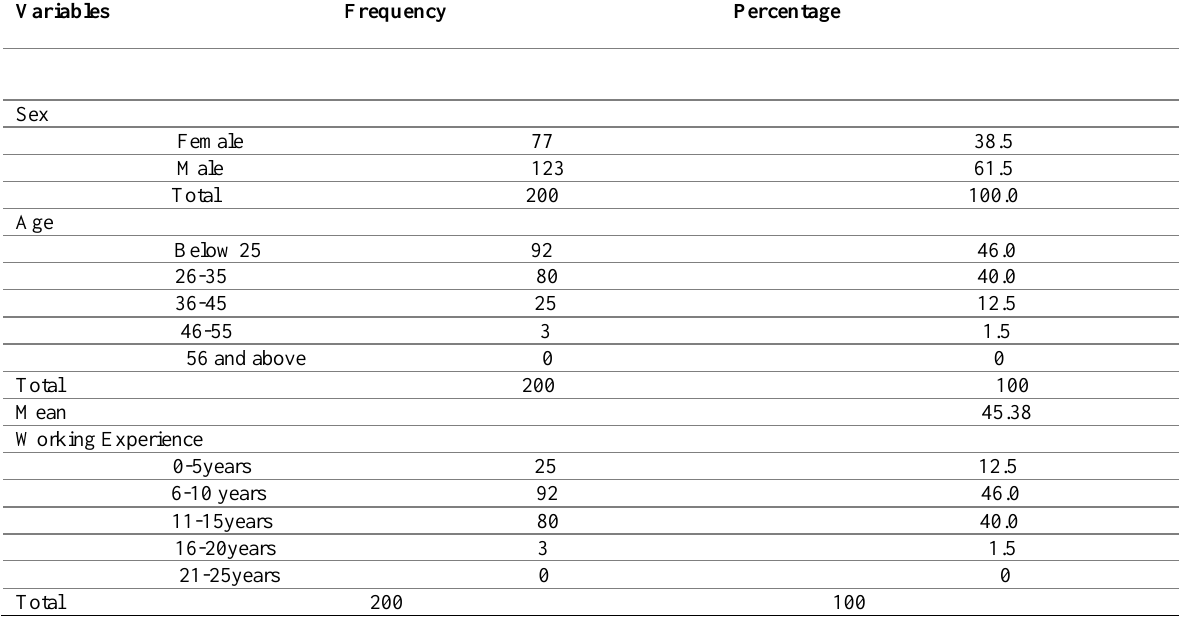
Table 1: Demographic characteristics of respondents